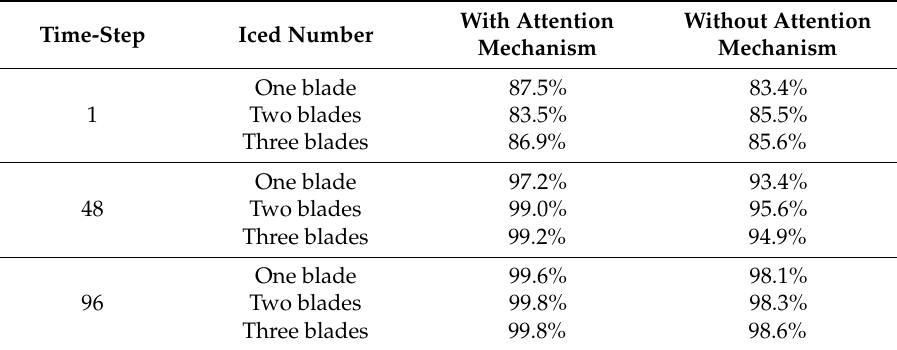
Figure 10. The accuracies of neural network with di ff erent time-step under two blades with ice accretion condition. Table 3. The accuracies of models with di ff erent time-step.